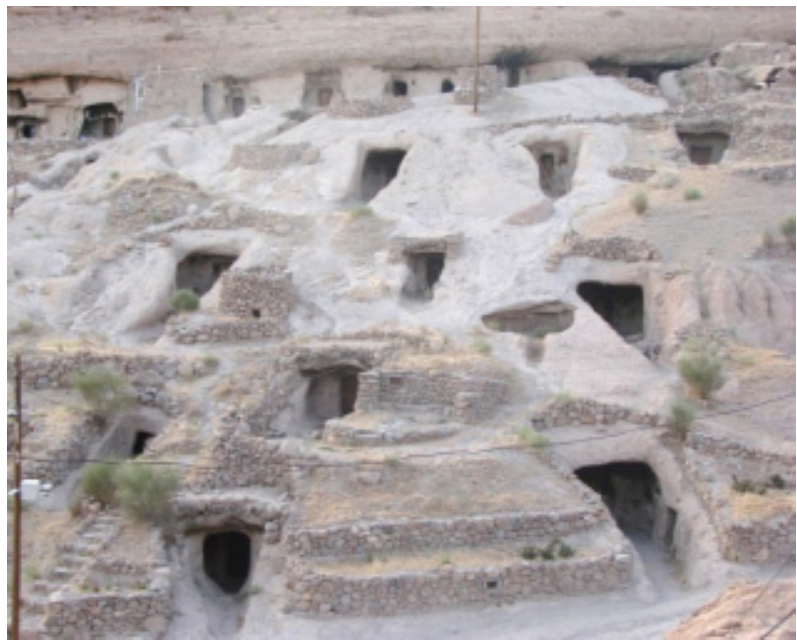
Figure 25. Special arrangement of buildings (excavators avoided laying two buildings on each other in two different levels).